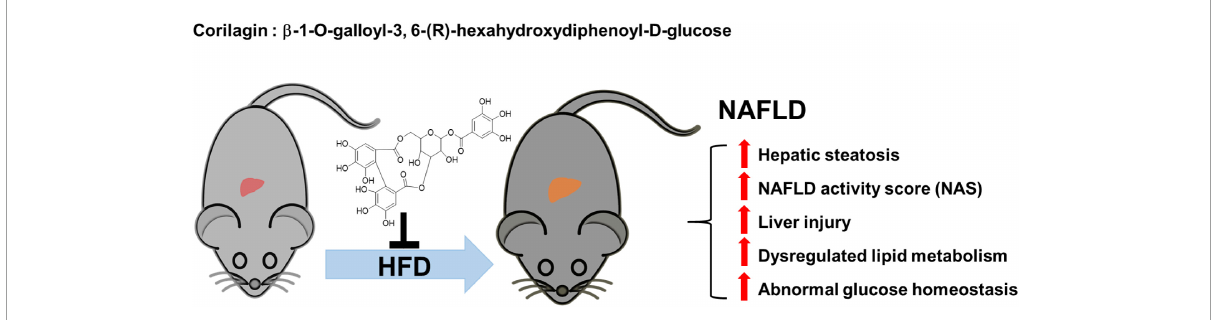
FIGURE9 The protective roles of Corilagin against NAFLD development in HFD-fed mice. HFD feeding induced NAFLD, which was accompanied by hepatic steatosis, high NAFLD activity score (NAS), liver injury, abnormal lipid metabolism and glucose homeostasis; however, Cori treatment significantly attenuated the progress of